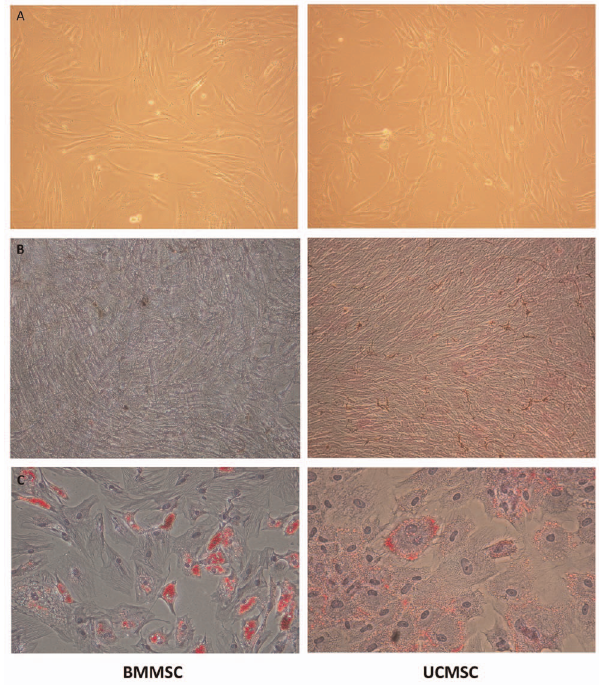
Figure 1. Comparison of BMMSCs and UCMSCs. ( A ) In vitro culture, BMMSCs and UCMSCs showed a similar spindle-shaped morphology (100 6 ). ( B ) UCMSCs had stronger potential for osteogen- esis than BMMSCs after 2-week induction (von Kossa staining, 100 6 ). ( C ) UCMSCs had lower potential for adipogenesis than BMMSCs after 2- week adipogenic induction (Oil red O staining, 200 6 ).